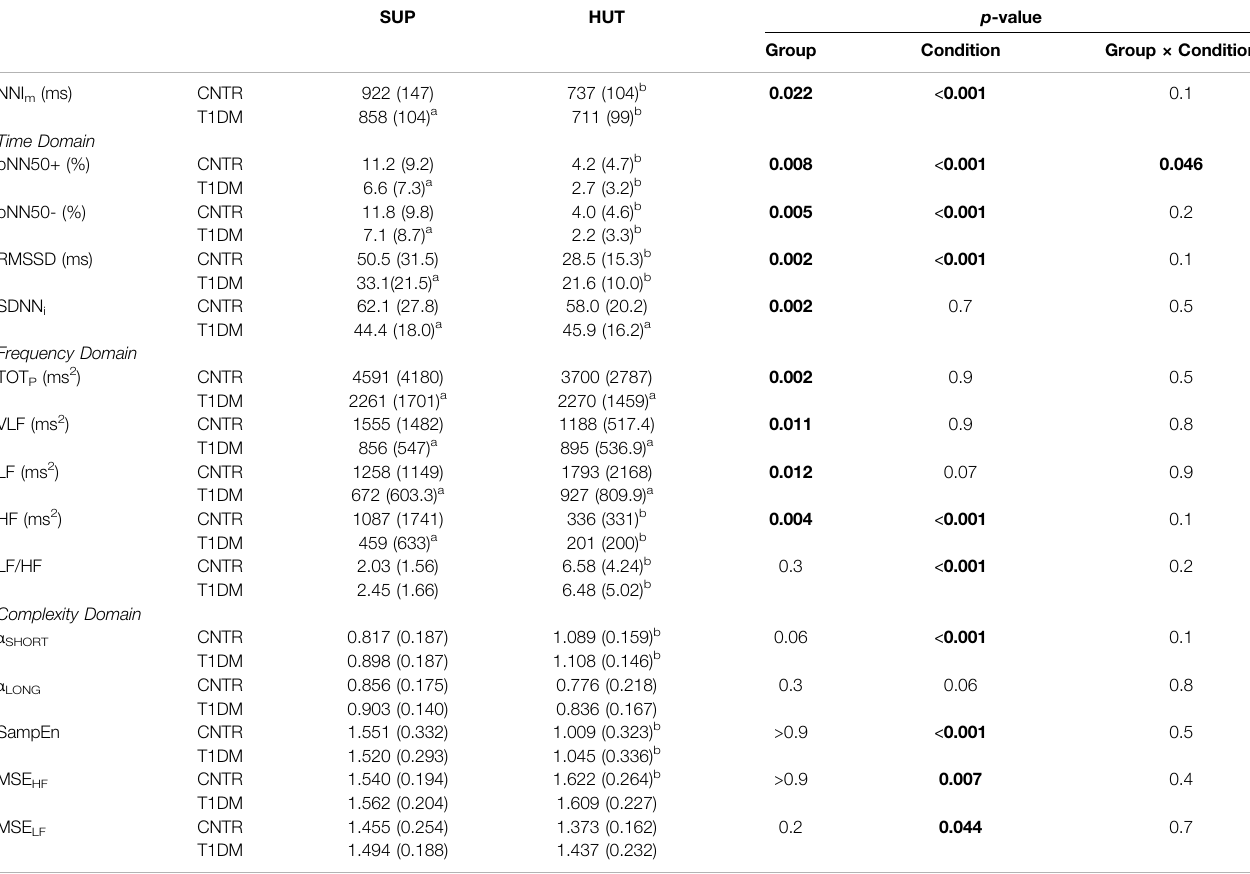
TABLE 2 | NNI m and HRV Indexes by groups and conditions: mean (SD) with statistical signi fi cance of the factors after linear mixed-effects model. SUP HUT p -value Group Condition Group ×